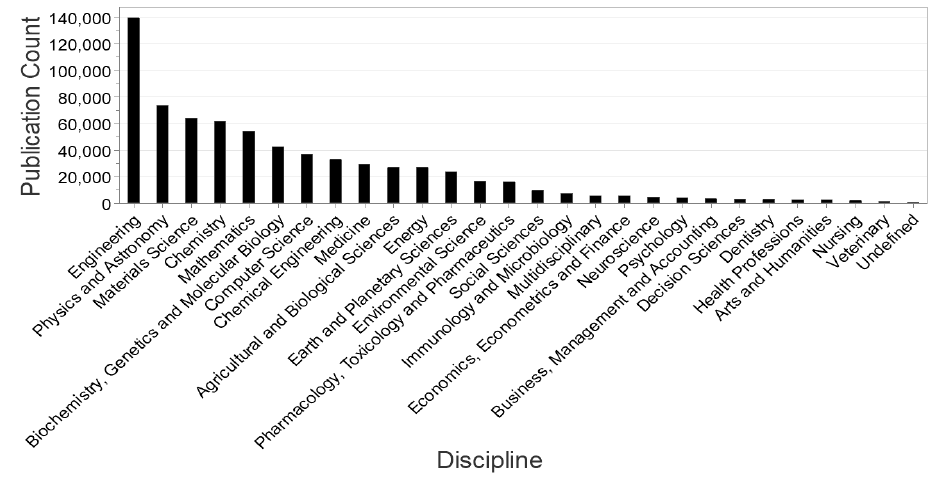
Figure 1. Publication counts listing stability in their titles. Data source: [13].